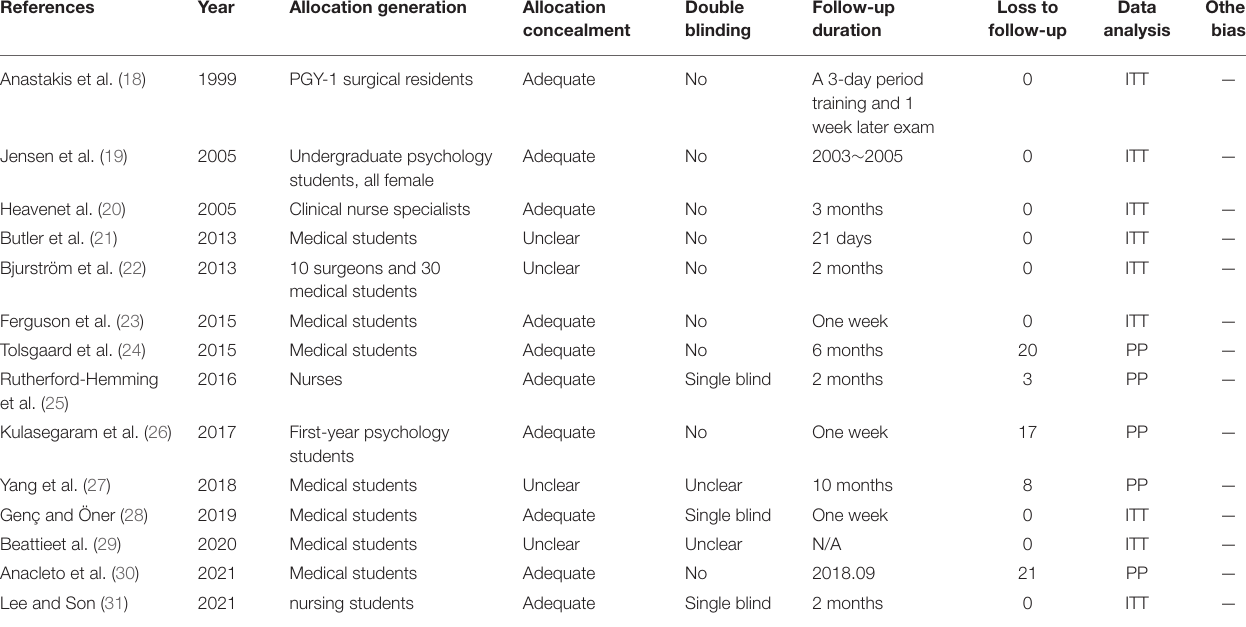
TABLE 3 | Methodological quality assessment of the included